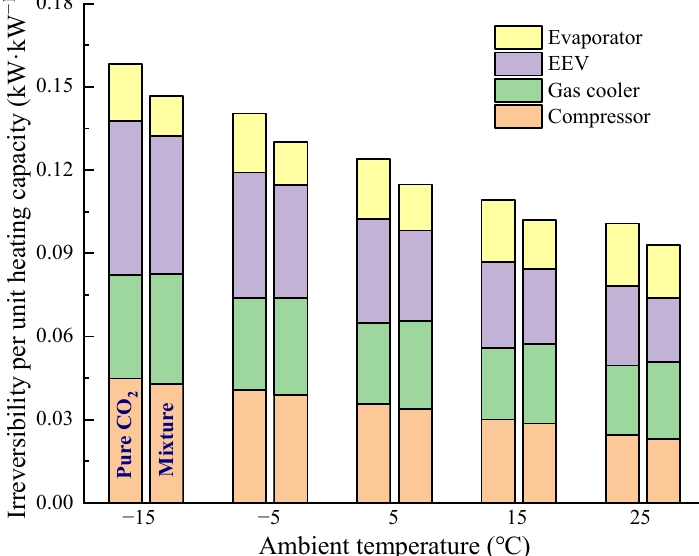
Figure 10. Comparison of the irreversibility per unit heating capacity with the pure CO 2 and determined CO 2 /R32 mixture under the varied ambient temperature.